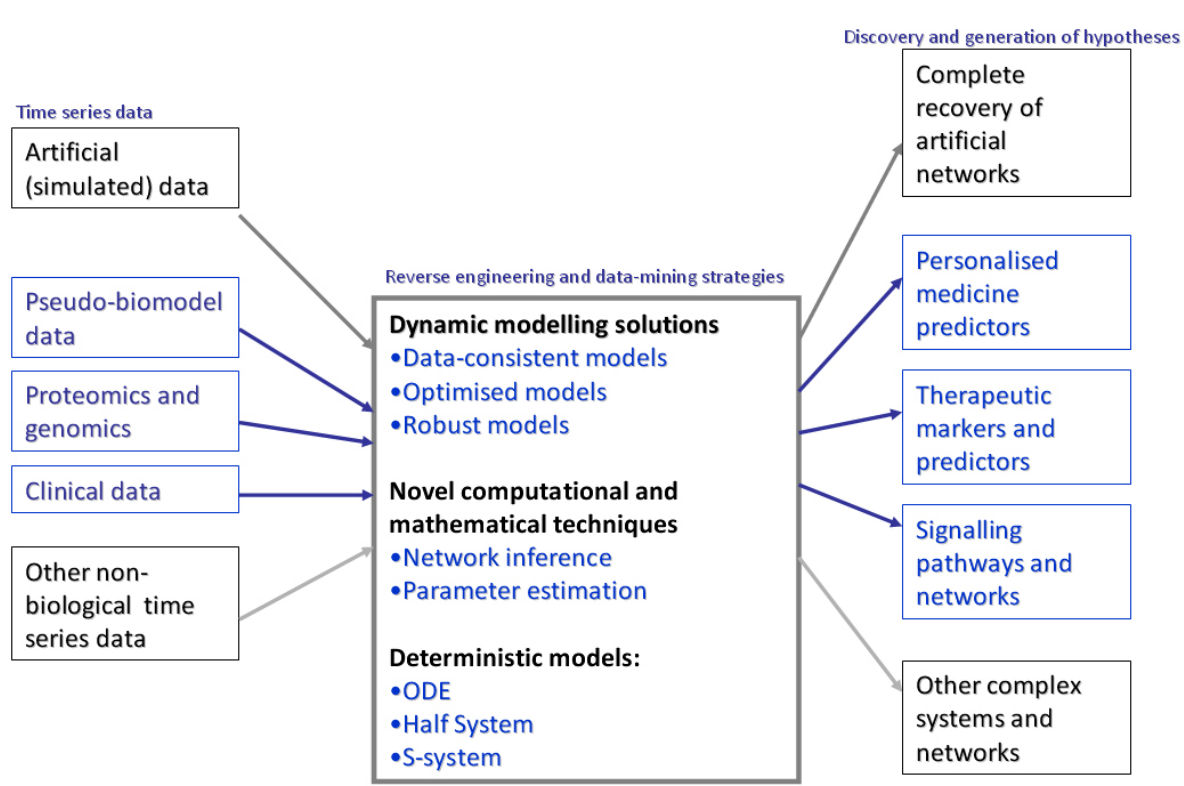
Figure 2. Reverse engineering: a mathematical and theoretical framework created to support multimodel integration and auto- mated construction of dynamic (i.e. deterministic, reconfigurable, self-organising and unsupervised) models from experimental time series